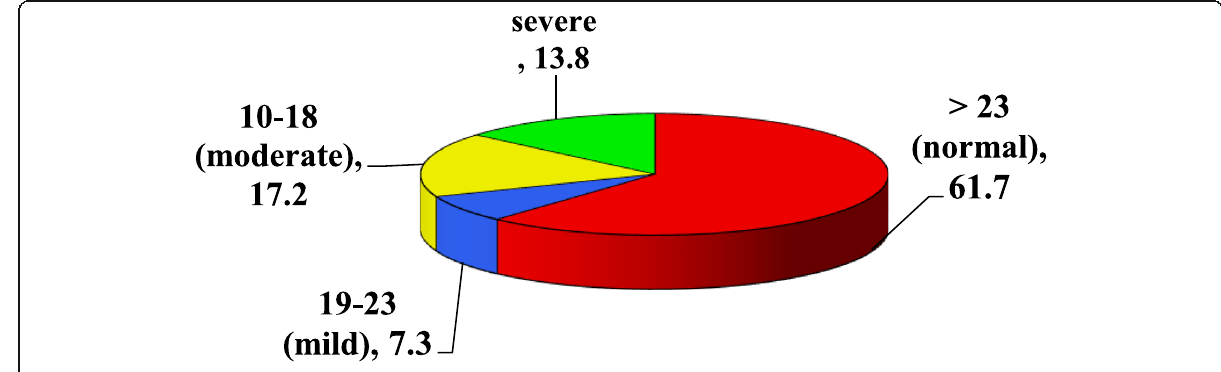
Fig. 1 Classification of causes of delirium and SSD in the studied